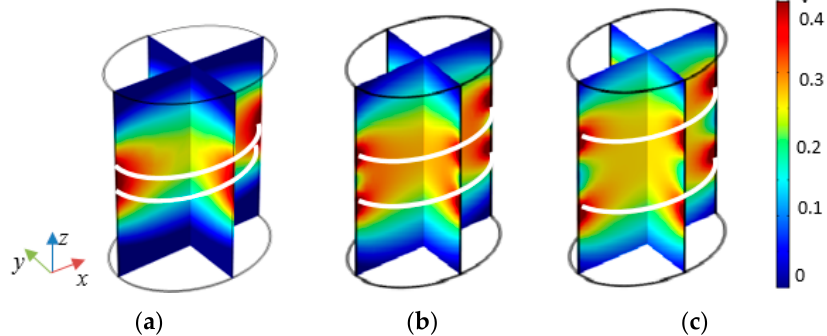
Figure 6. Maps of V max in a small loop ( S = 1 cm 2 ) inside the human body for different values of the separation distance h t between the solenoids: ( a ) h t = 50 mm; ( b ) h t = 100 mm; ( c ) h t = 150 mm.